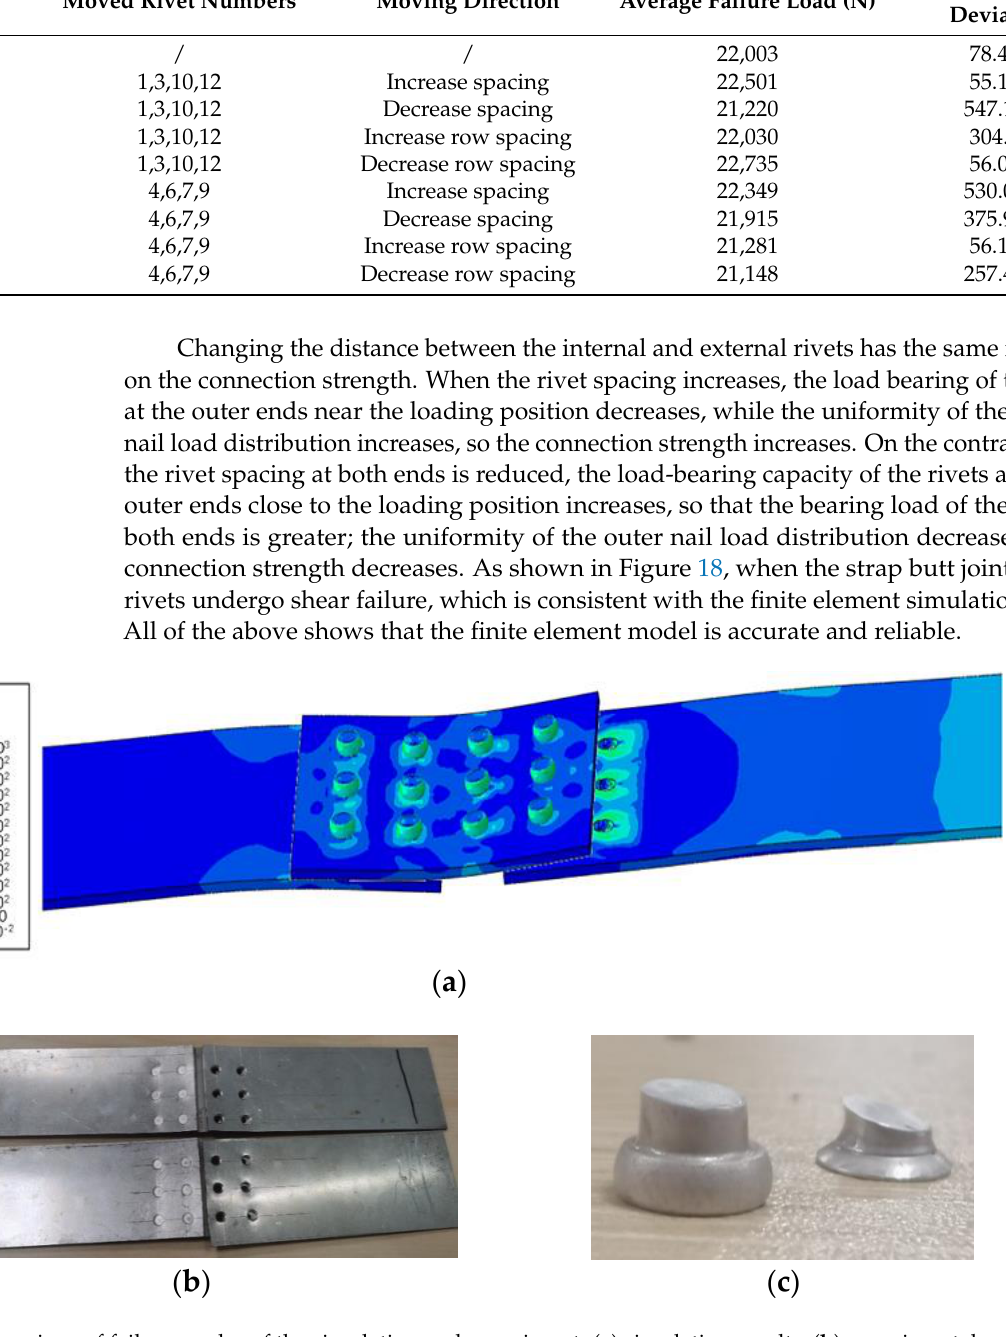
Table 2. Average value and standard deviation of static tensile strength of different experimental groups.